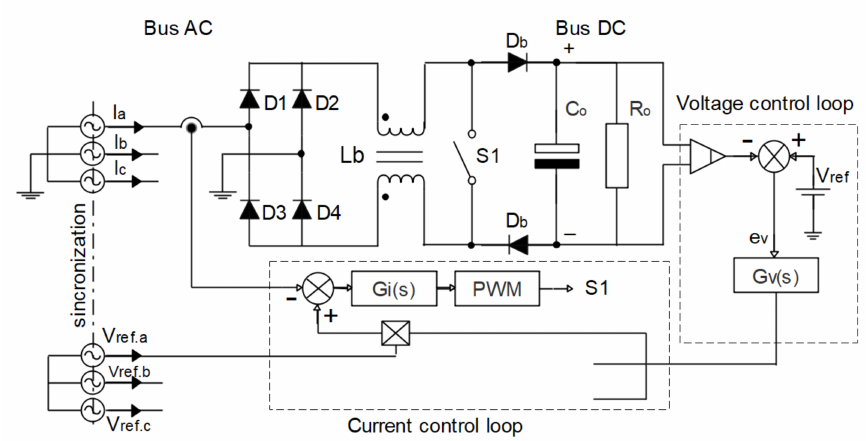
Figure 6. Modular three-phase rectifier with BOOST converter and coupled